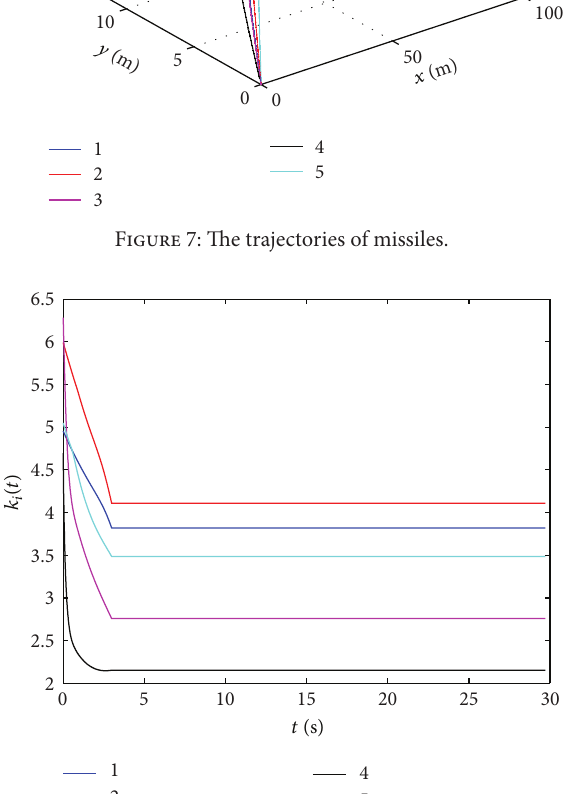
Figure 8: The trajectories of proportional